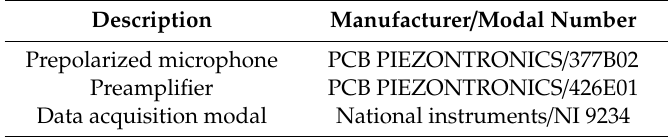
Table 2. Parameters of sound measurement devices of A-CPX